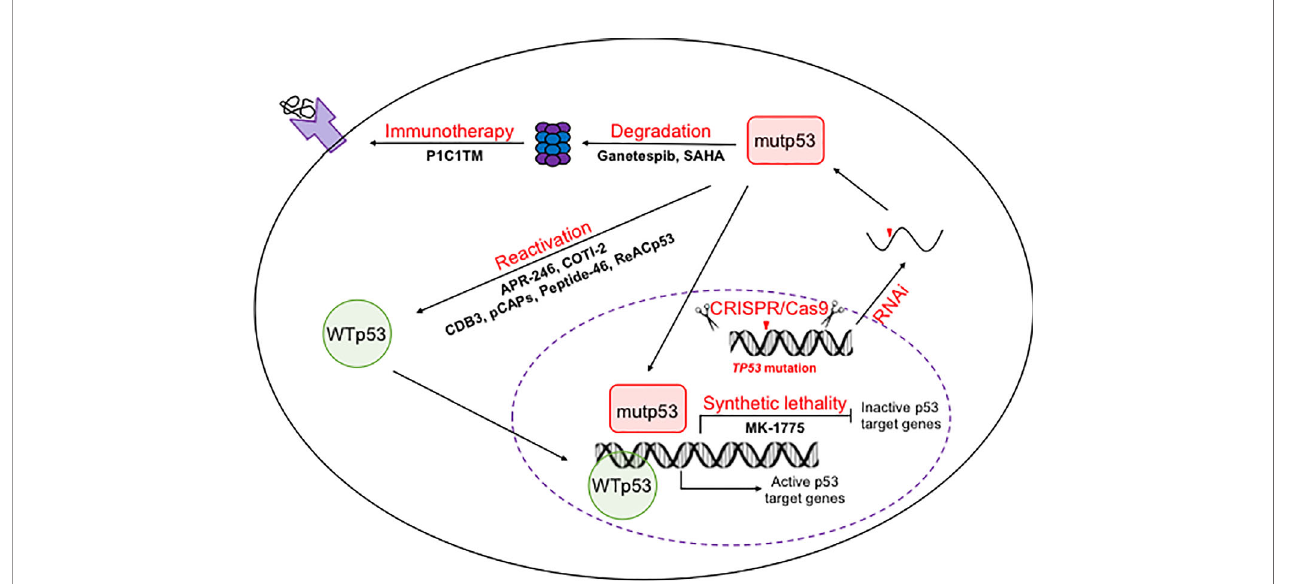
FIGURE 1 | Therapeutic strategies to target p53 mutants. On the DNA level, mutations in TP53 allele could be reversed back to wild-type ones using CRISPR/Cas9 mediated genome editing. One the mRNA levels, mutp53 mRNA could be silenced by RNAi. On the protein level, mutp53 could be reactivated or trageted for degradation by both small molecule compounds and small peptides. The inability of mutp53 to activate its downstream target genes provides an opportunity for synthetic lethality based therapy. The mutant peptides produced by degradation of mutp53 makes immunotherapies